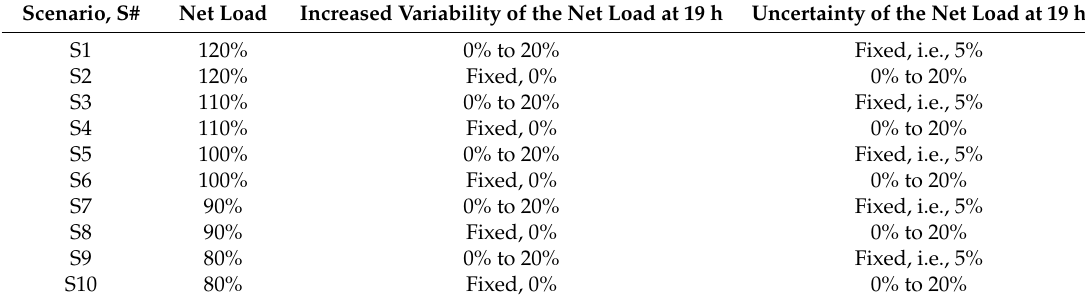
Table 2. Scenarios for three parameters: net load, increased variability, and uncertainty.